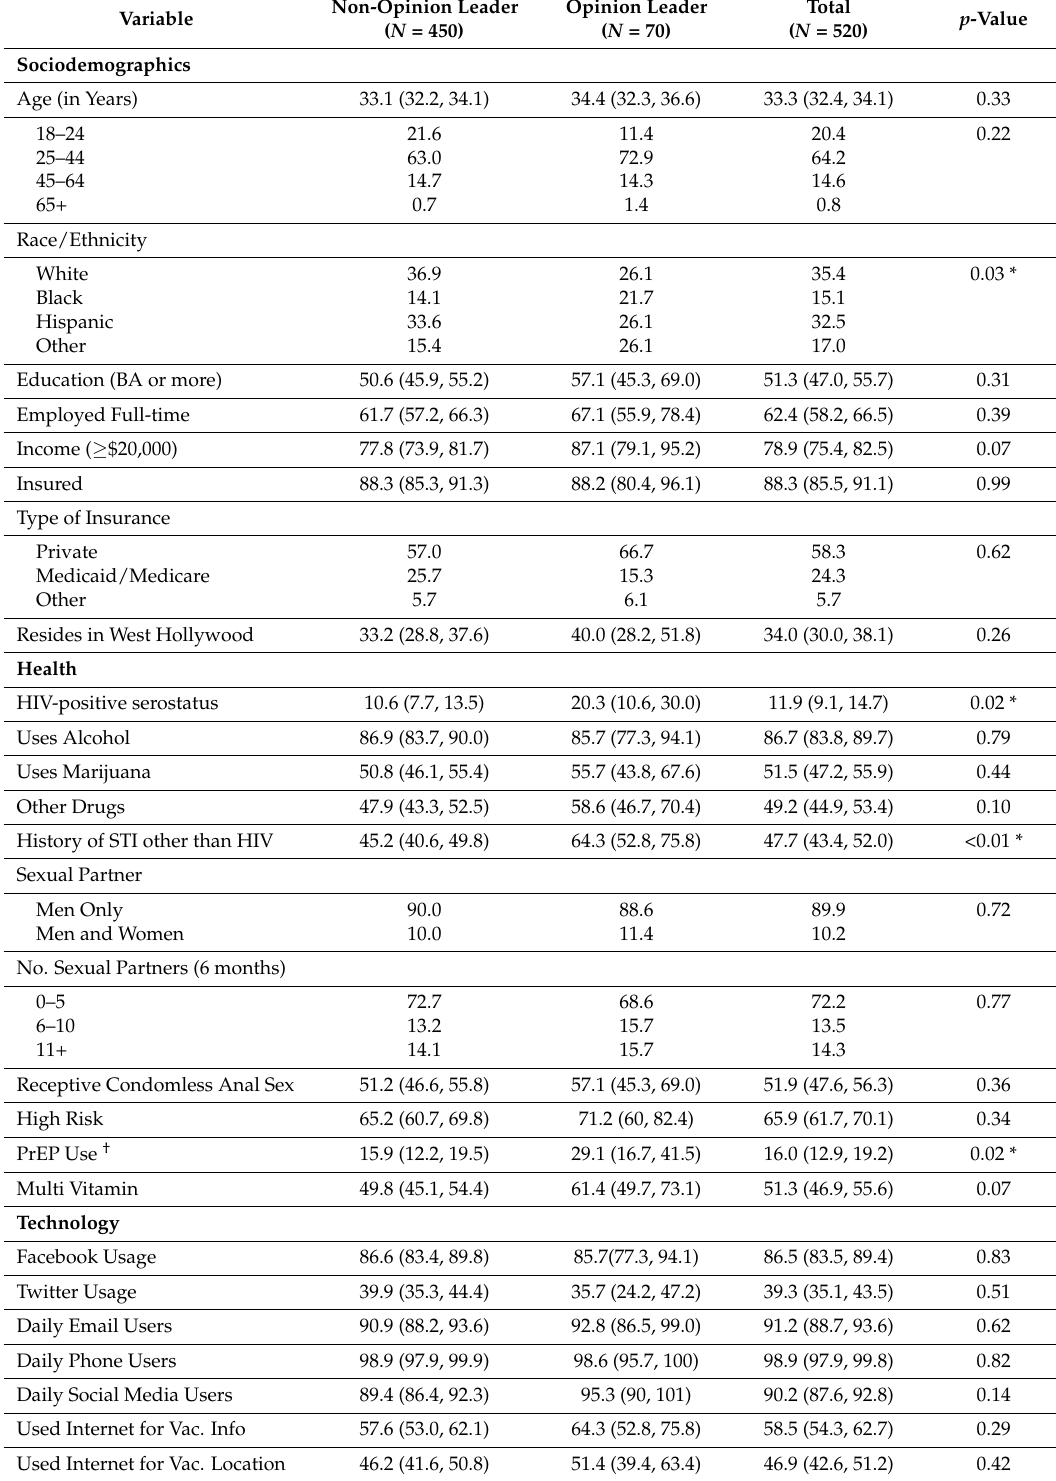
Table 1. Percentages of opinion leadership (yes/no) by sociodemographic, health, and technology use covariates using chi-square significance